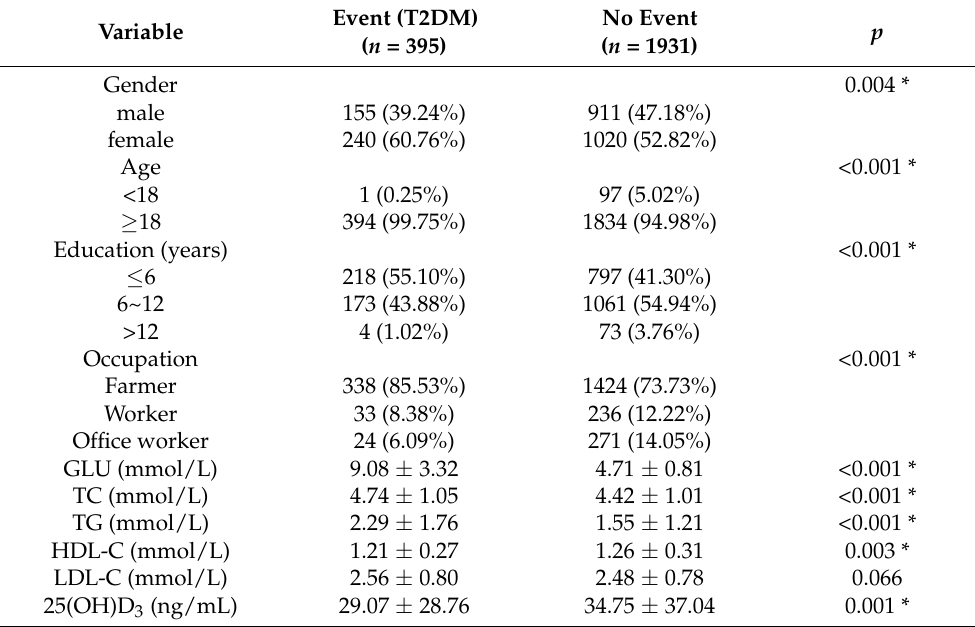
Table 1. Characteristics of the study population according to the presence of